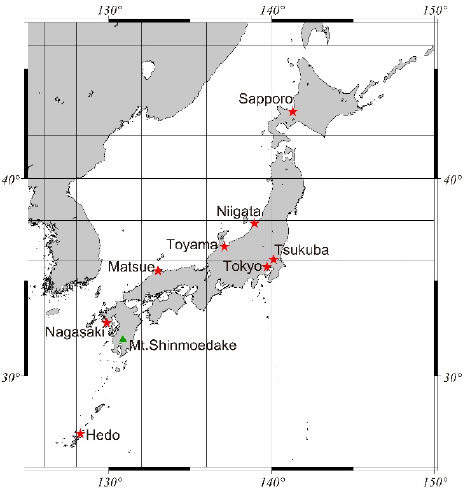
Figure 1. The location of the Shinmoedake and 8 LiDAR (light detection and ranging) sites.Green triangle and red star indicate the locations of Shinmoedake and a LiDAR site, respectively.